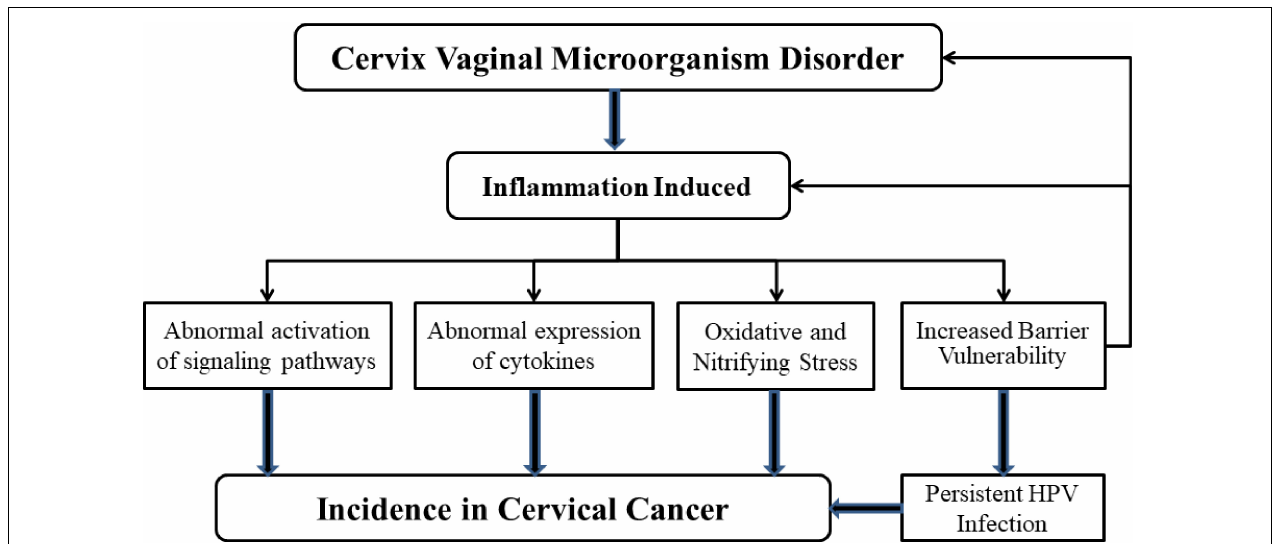
FIGURE 3 | Mechanisms of microbial dysregulation and inflammation leading to cervical cancer. When the balance of microbial environment of female reproductive tract is upset, the inflammatory response is activated. H 2 O 2 , the amount of lactic acid decreases because of the increase in the number of anaerobic bacteria. At the same time, the production of a large number of pro-inflammatory cytokines affects the protective ability of the mucosal epithelial barrier. These phenomena can increase the likelihood of persistent HPV infection, which can lead to cervical cancer. Abnormal expression of cytokines and abnormal activation of signal pathways also lead to the occurrence of cervical cancer. It is important to note that the presence of HPV could also influence microbial homeostasis and the activation of inflammation-related